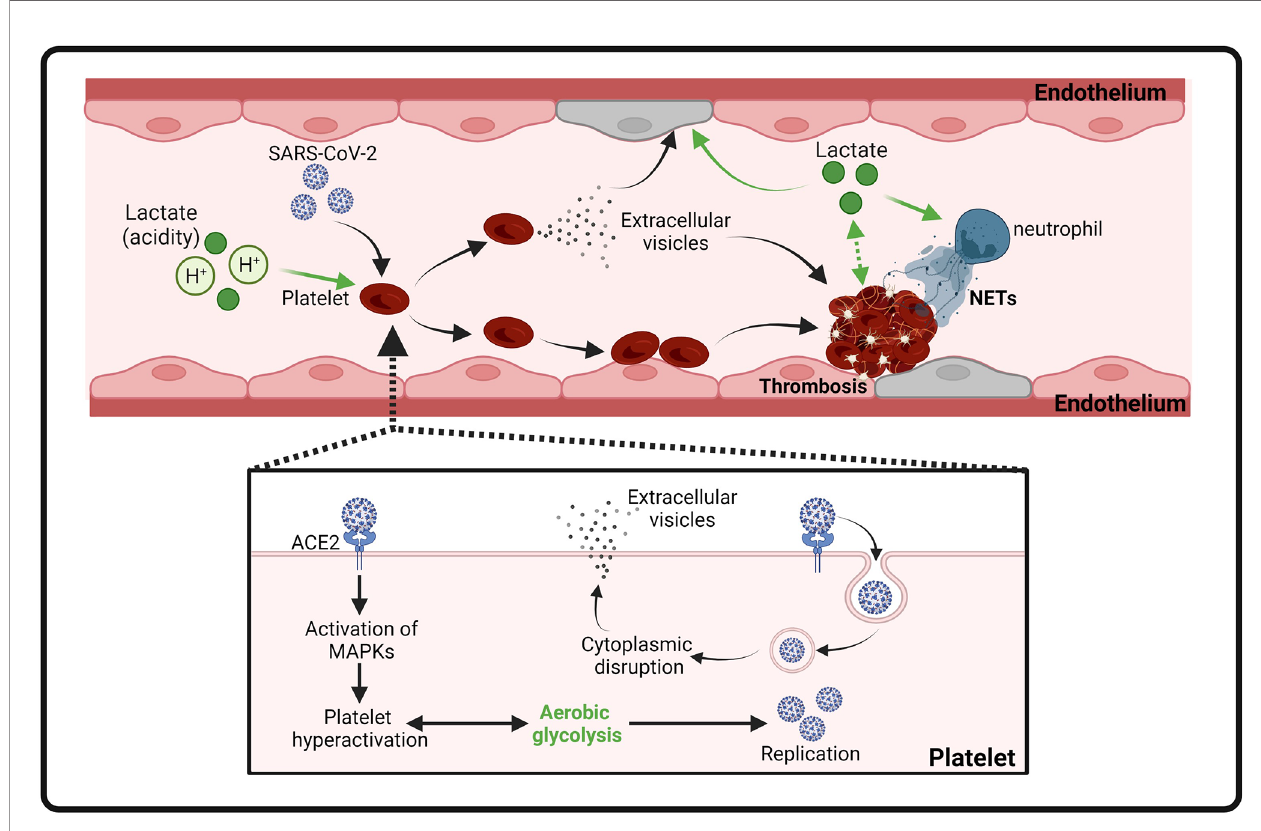
FIGURE 3 | Proposed model of platelet activation, thrombosis and endothelial cell injury induced by SARS-CoV-2 infection and lactate. Binding of SARS-CoV-2 spike protein to ACE2 leads to MAPK signaling activation and subsequent platelet activation. Activated platelets release coagulation factors and cytokines to promote thrombosis. Internalization of SARS-CoV-2 virions induces the release of extracellular vesicles from platelets to facilitate thrombosis. In addition, lactate (acidity) also contributes to thrombosis by promoting activation of platelets, endothelial cells, and